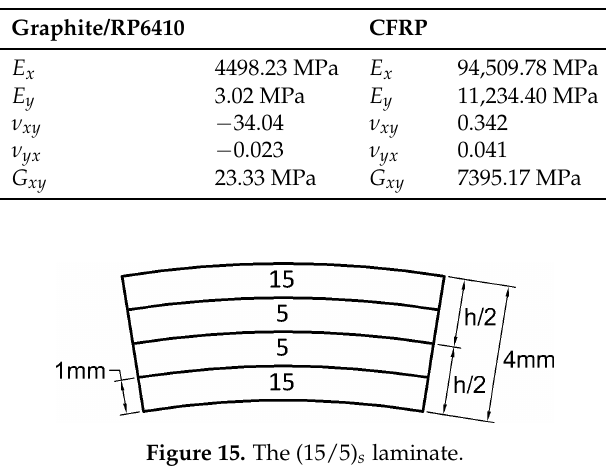
Table 4. Engineering constants for ( 15/5 ) s using material from Table 2 and CFRP using material from Table 1.